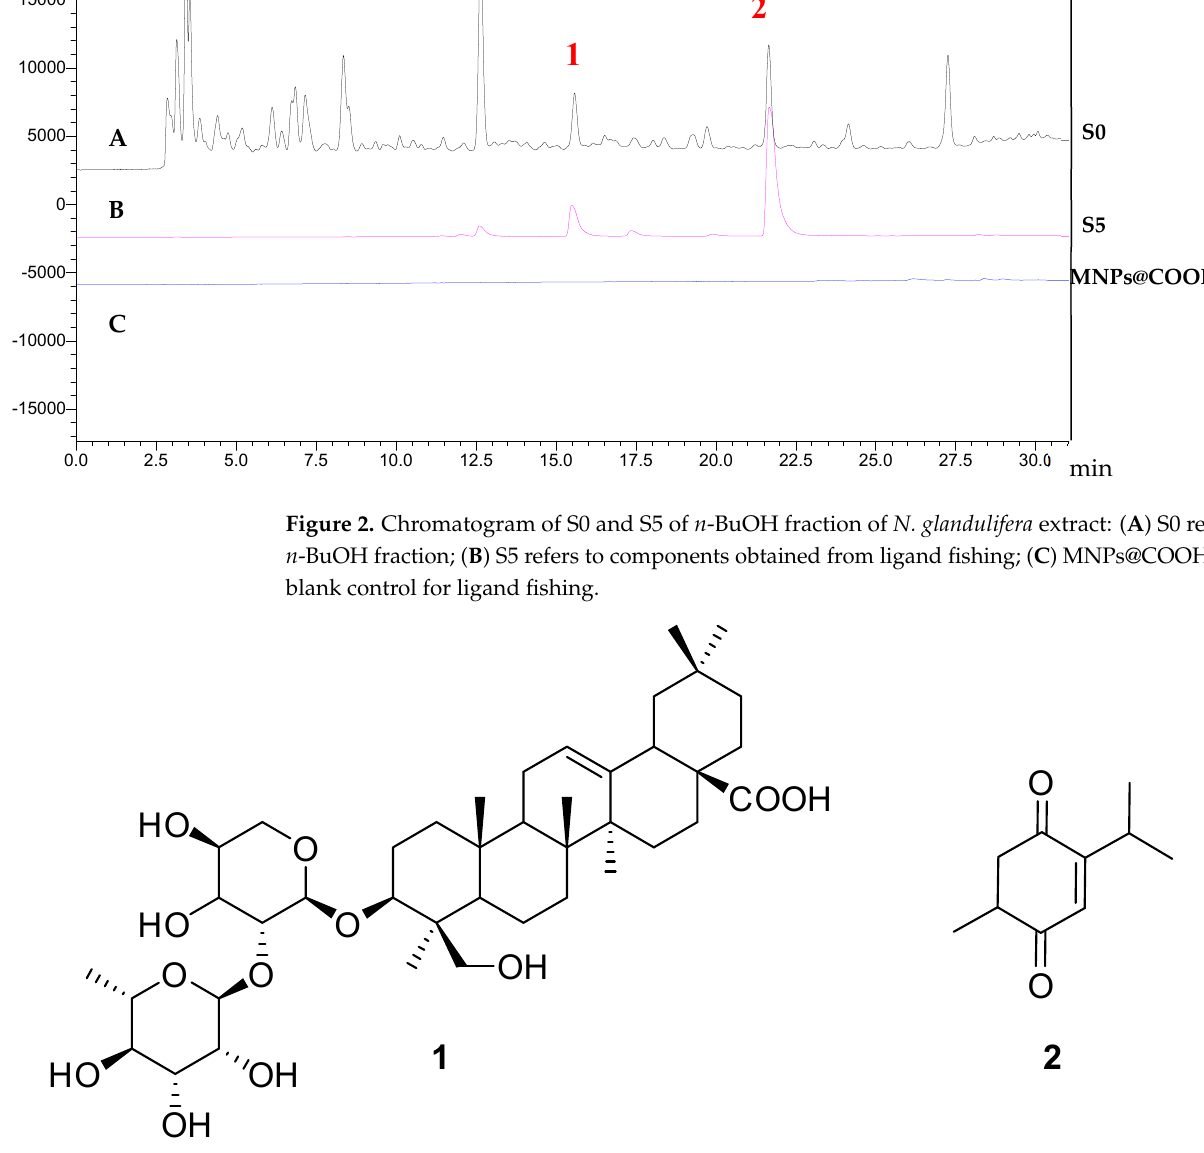
Figure 3. Identified chemical structures of MAO - B inhibitory compounds.